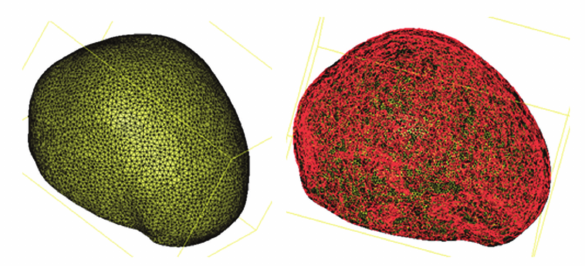
Figure 19: 3D finite element model of cranial cavity is